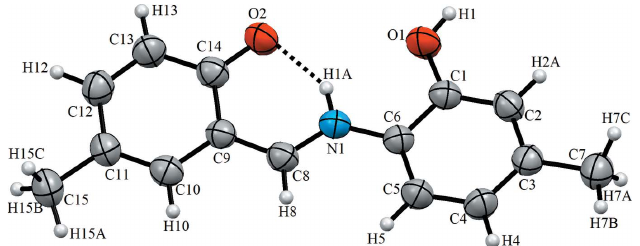
Figure 1 The molecular structure of the title compound, with displacement ellipsoids drawn at the 40% probability level. Dashed lines denote the intramolecular N—H (cid:3)(cid:3)(cid:3) O hydrogen bond (Table 1) forming an S (6) ring